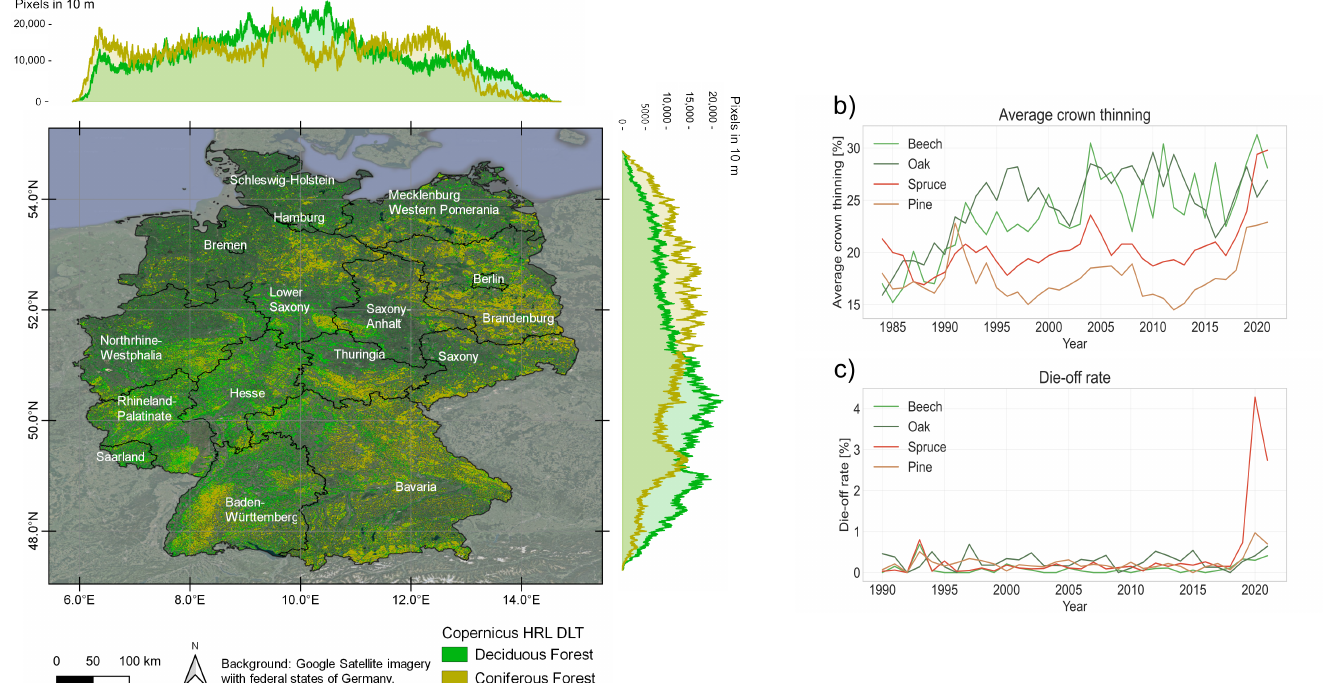
Figure 1. General overview on the forest area and forest types ( a ) according to the Copernicus High-Resolution Layer (HRL) Dominant Leaf Type 2018 (DLT) [12]. In addition, statistics on average crown thinning ( b ) and die-off rates ( c ) are displayed based on data from the crown condition survey (Waldzustandserhebung)